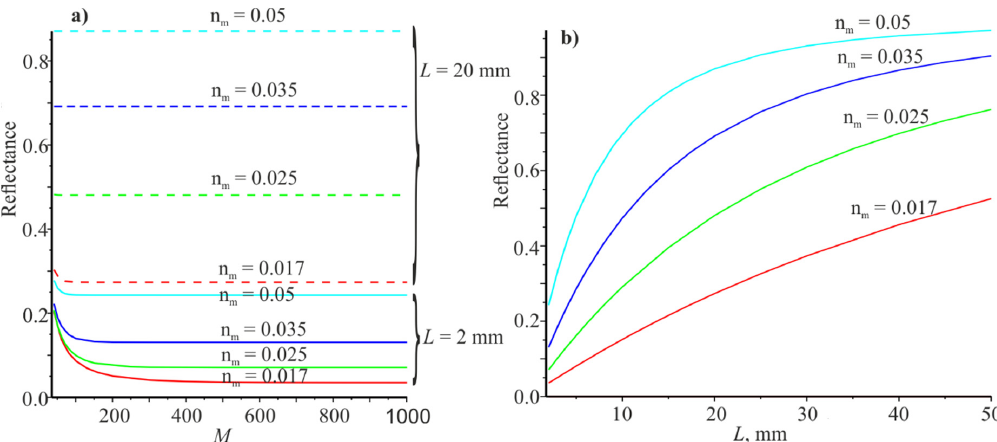
Figure 2. Dependences of the reflection coefficients on M for L = 2 mm (4 lower curves for) end L = 20 mm (4 upper curves) ( a ). The dependence of the reflection coefficients on L at M = 501 ( b ). The red, green, blue, and cyan curves correspond to the modulus coefficients of the refractive index n m : 0.017, 0.025, 0.035, 0.05.